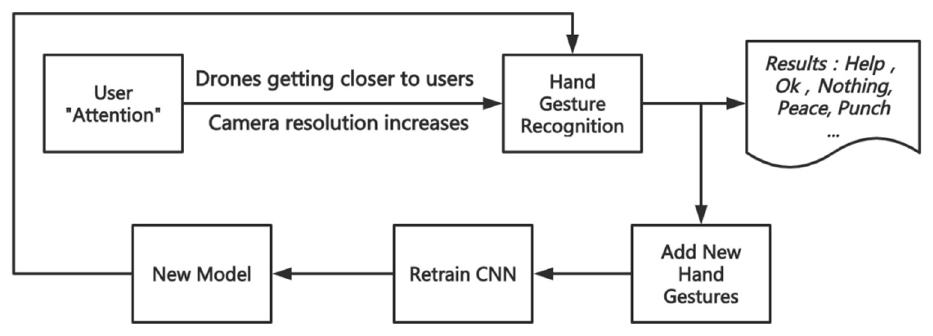
Figure 6. Workflow of the human hand gesture recognition.